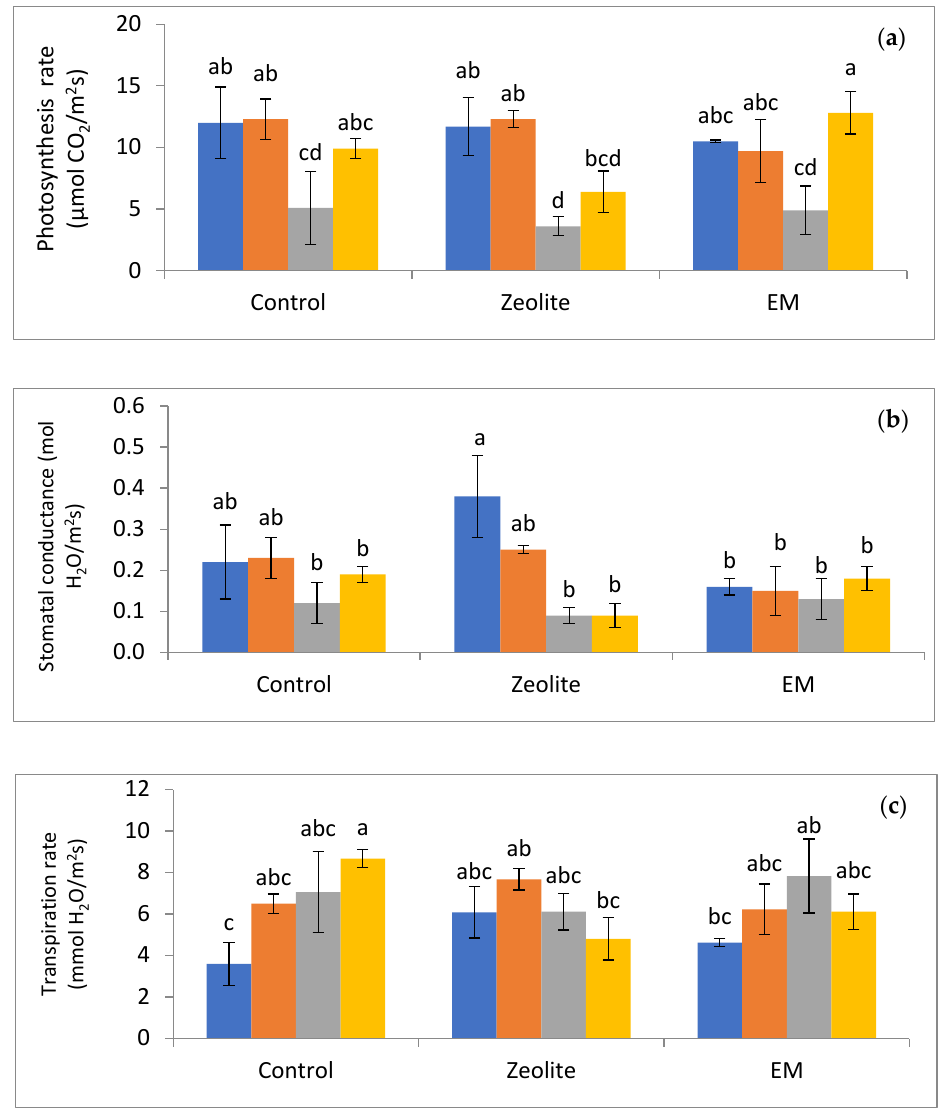
Figure 1. ( a ) Photosynthesis rate, ( b ) stomatal conductance, ( c ) transpiration rate, and ( d ) internal CO 2 concentration in leaves of the apple plants. All the values are averages of four replications ± standard error. The different letters in the same column show statistically significant differences among the twelve subtreatments according to the Duncan test ( p ≤ 0.05) with the larger values corresponding to the letter “a”. I: no NaCl, II: NaCl 50 mM, III: NaCl 50 mM + seaweed extract spraying, IV: NaCl 50 mM + ceramic powder spraying. EM treatment included compost addition. The inclusion of zeolite in the substrate affected stomatal conductance, seeing that the statistically significantly highest value was noted in the respective treatment in nor- mal conditions. On the other hand, when plants received compost and microorganisms, the stomatal conductance showed significantly lower values in the absence of salinity. However, the presence of NaCl was not associated with lower stomatal conductance in this experiment since no significant differences in stomatal conductance were recorded between normal and salinity subtreatments in any treatment. Conversely, the algal spraying (III) or the application of the ceramic powder spray solution (IV) led to signifi- cantly lower values of the aforementioned parameter in the control or zeolite treatments. The application of algae solution or ceramic powder had no apparent negative effect on the stomatal conductance of the EM-treated plants (Figure 1b). At the same time, the transpiration rate was higher in the zeolite treatment and in the EM treatment compared with the control under normal conditions. Administration of NaCl contributed to an increase in the transpiration rate in all treatments, but was not associated with significant differences between treatments. In addition, the subtreatment in which plants were sprayed with algal extract in the presence of salinity (III) showed similar transpiration rates in all treatments, which were also not significantly different from the corresponding subtreatments in which plants were given NaCl only (II). The control subtreatment in which the plants had ceramic powder applied in the presence of salinity (IV) showed a significantly higher transpiration rate compared with the normal conditions subtreatment (I), but a similar difference was not found in the other two treatments (Figure